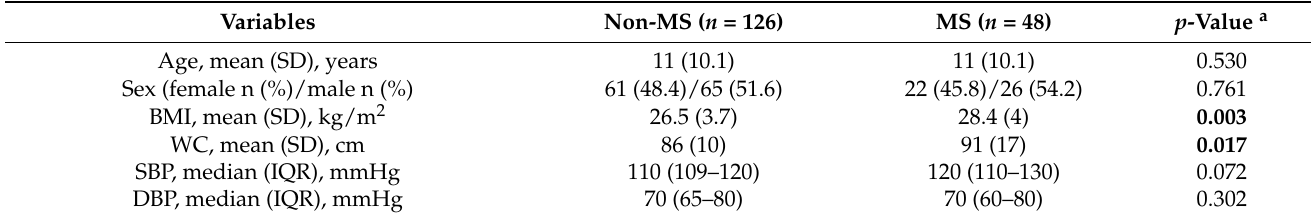
Table 1. Characteristics of the adolescents in the non-MS and MS